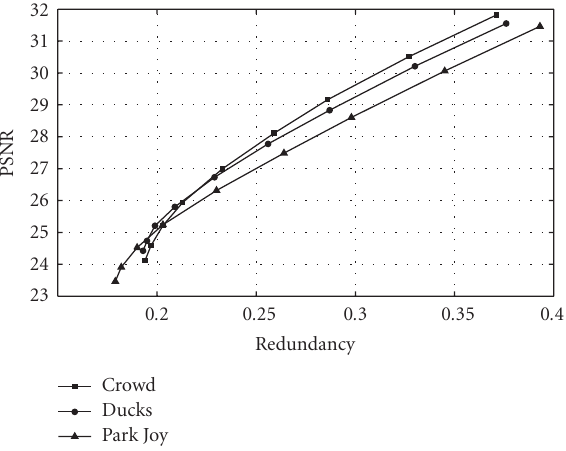
Figure 8: Redundancy versus PSNR in case of one descriptor is completely lost for di ff erent values of QP Ducks take o ff , and Crowd Run video sequences.